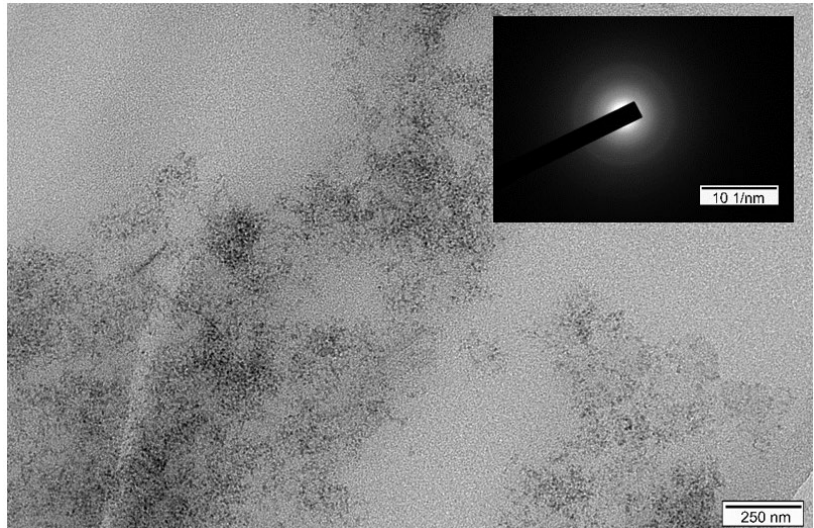
Figure 2. SEM images of non-delaminated ( a ) and delaminated iron-based LDH ( b ).